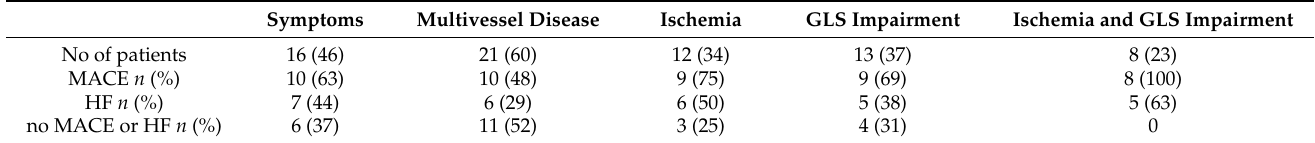
Table 2. Primary and Secondary Outcome According to Symptoms, Multivessel Disease, Ischemia and